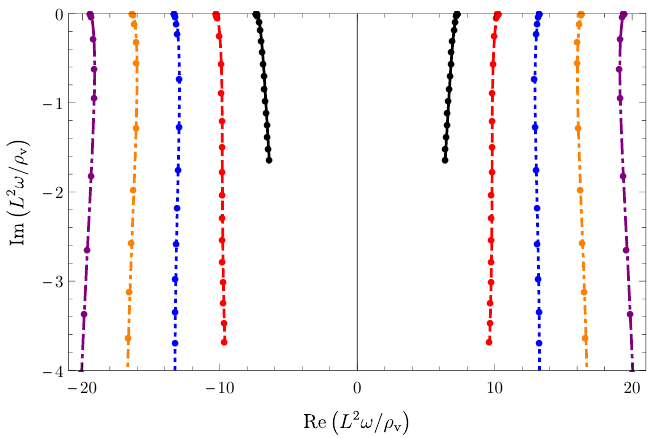
Figure 3. The complex frequency plane ! , in units of (cid:26) v =L 2 , showing QNM frequencies of the (cid:13)uc- tuation (cid:26) 0 . The curves (solid black, dashed red, dotted blue, dash-dotted orange, dash-dash-dotted purple) are simply to guide the eye for each QNM’s motion down into the complex plane as Q in- creases from 10 (cid:0) 5 to 10 (cid:0) 1 . The curves connect the solid disks, which are separated by 10 data points. in (cid:12)gure 2(a) to Q = 0 : 1 in (cid:12)gure 2(b), the QNMs’ real parts change very little,